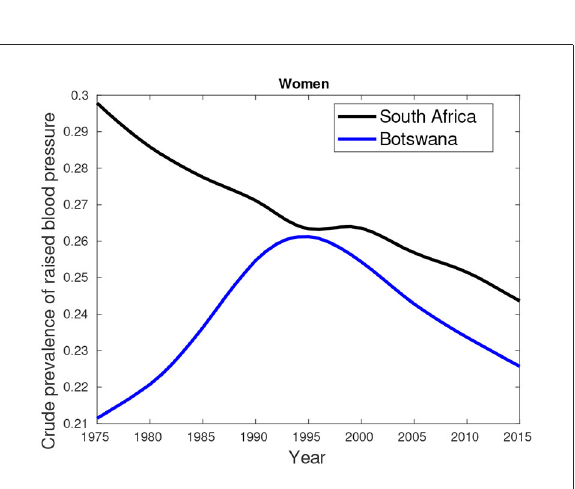
FIGURE8 Crude prevalence of raised blood pressure for female trends in Botswana and South Africa from 1975 to